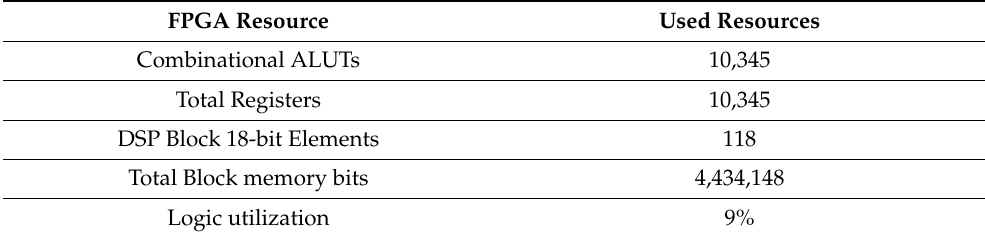
Table 3. FPGA chip statistics, including the full system.